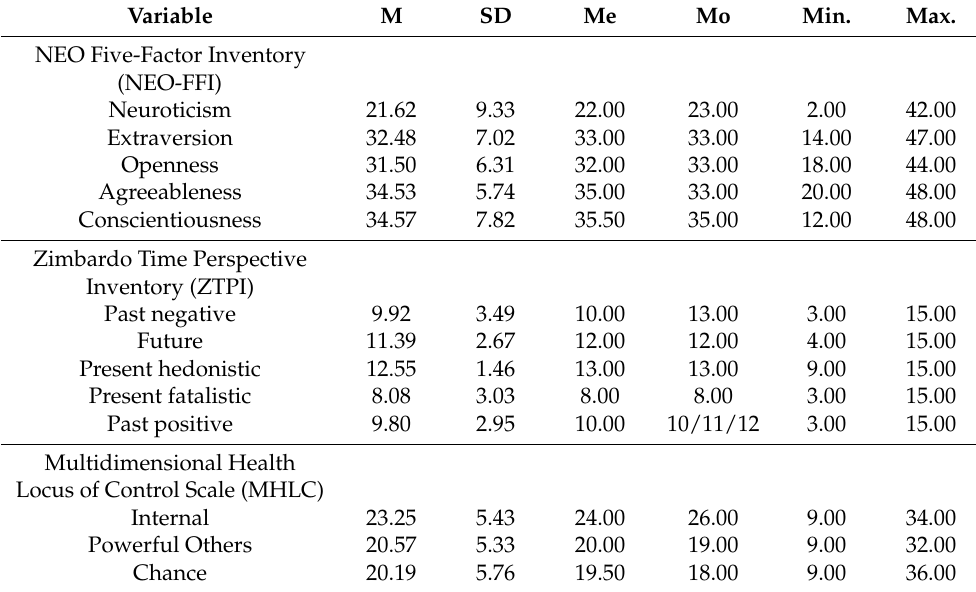
Table 3. Descriptive statistics of psychological variables in the study